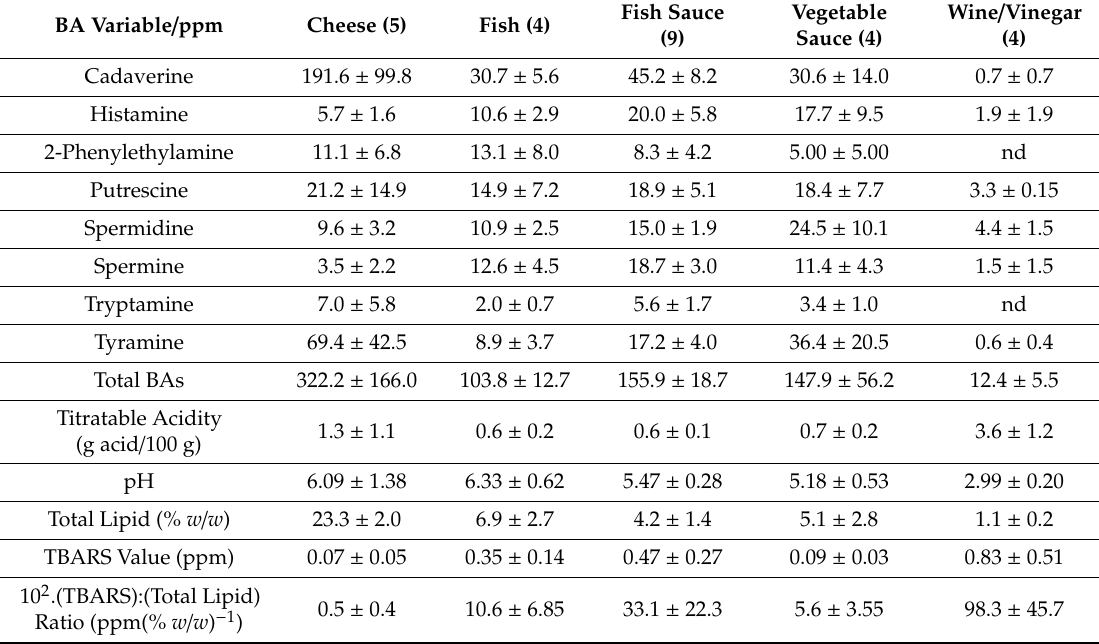
Table 2. Biogenic amines (BA) contents and quality indices of fermented foods investigated. Mean ± SEM BA levels, and titratable acidity (TA), pH, total lipid, thiobarbituric acid-reactive substances (TBARS) and (TBARS):(total lipid) ratio values, for five classes of fermented food products (cheese, fish, fish sauce / paste, vegetable sauce, and wine / vinegar) purchased at a range of U.S. retail outlets (bracketed numbers represent the number of di ff erent products analyzed for each classification).